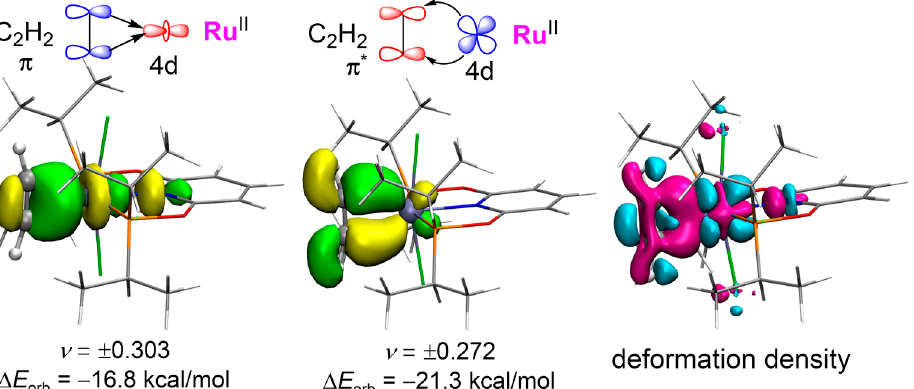
Figure 6. Shape of the charge NOCV orbitals (isovalue = 0.05 a.u.) associated with the orbital interactions ∆ E orb and the total electron deformation density for C 2 H 2 adsorbed by CAT − 1 (isovalue = 0.0025 a.u.). The eigenvalues ( υ ) of the fragment orbitals give the size of the charge migration. The color code for the charge transfer is pink → cyan.